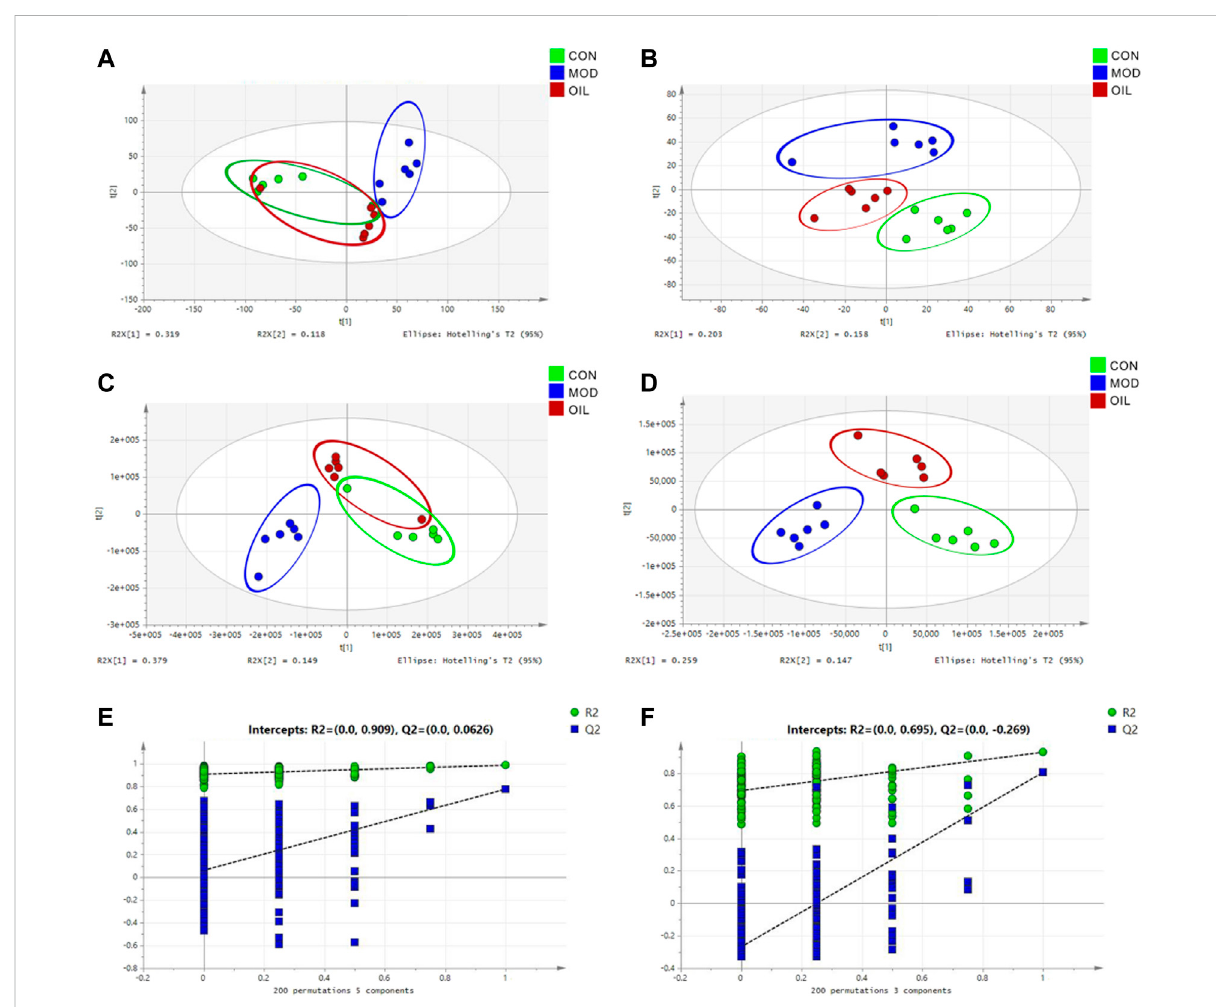
FIGURE 3 PCAscoreplot (A,B) ,PLS-DAscore plot (C,D) andvalidationplotofthePLS-DAmodel (E,F) ofcontrol group,modelgroupand A.mongolica oil group in positive and negative ion